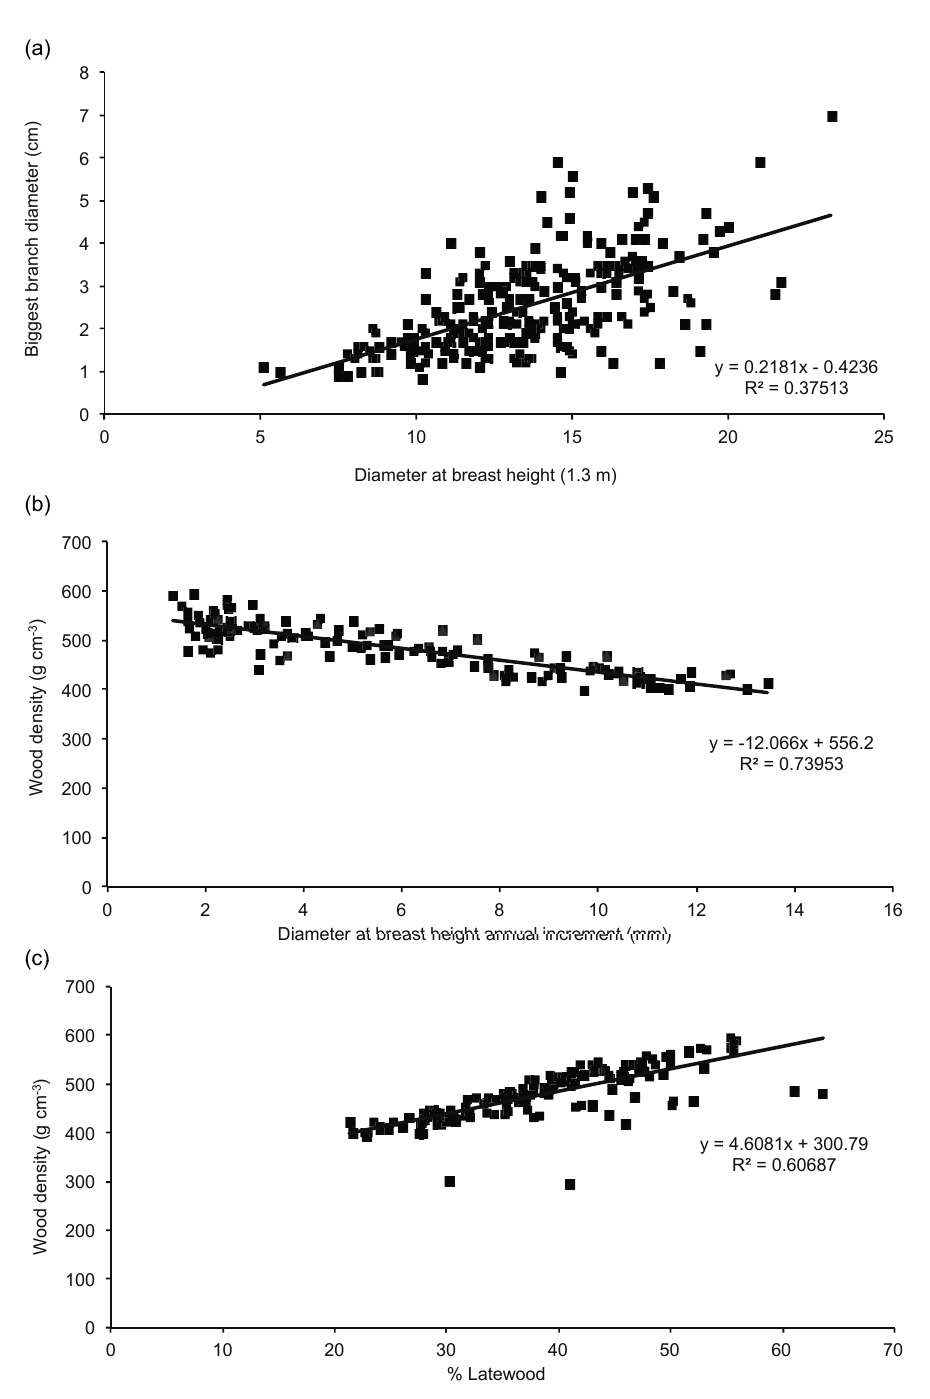
Figure 3. Relationship between diameter at breast height (DBH) and largest branch diameter ( a ); DBH annual radial increment and wood density ( b ); and percentage of latewood and wood density ( c ) for jack pine 25 years following planting in Quebec, Canada.